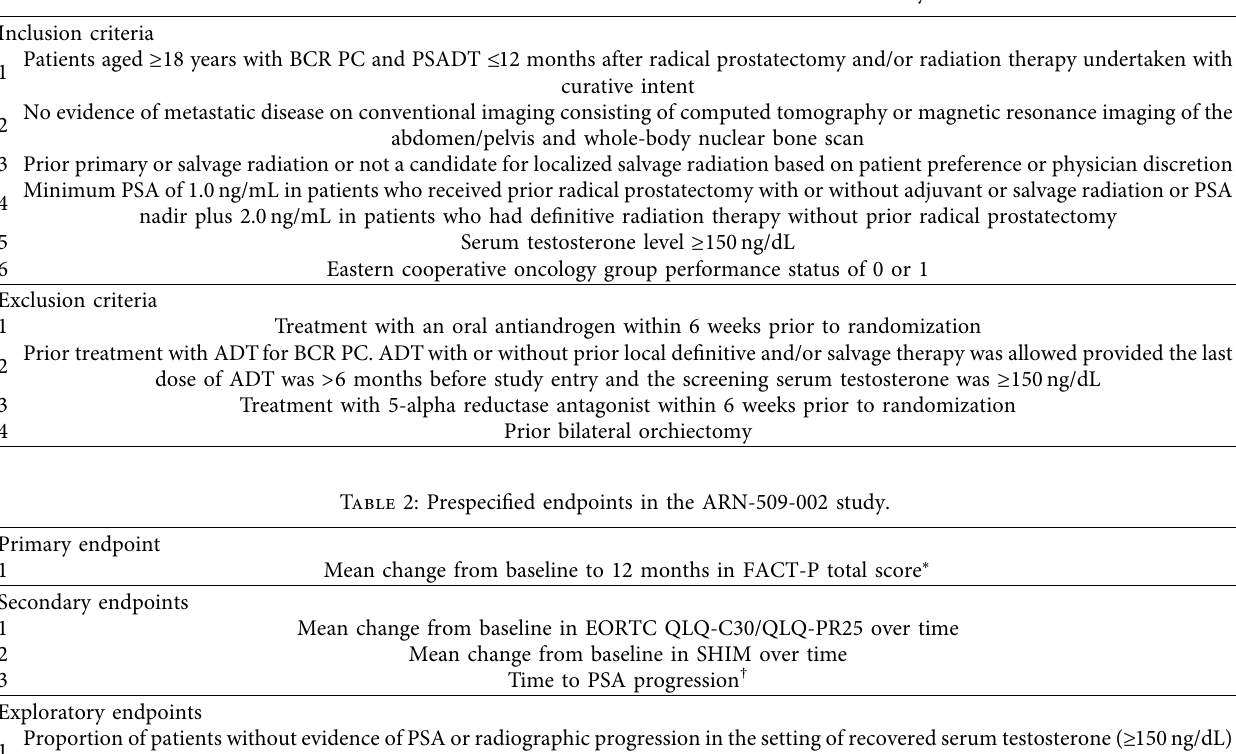
Table 1: Inclusion and exclusion criteria in the ARN-509-002 study.